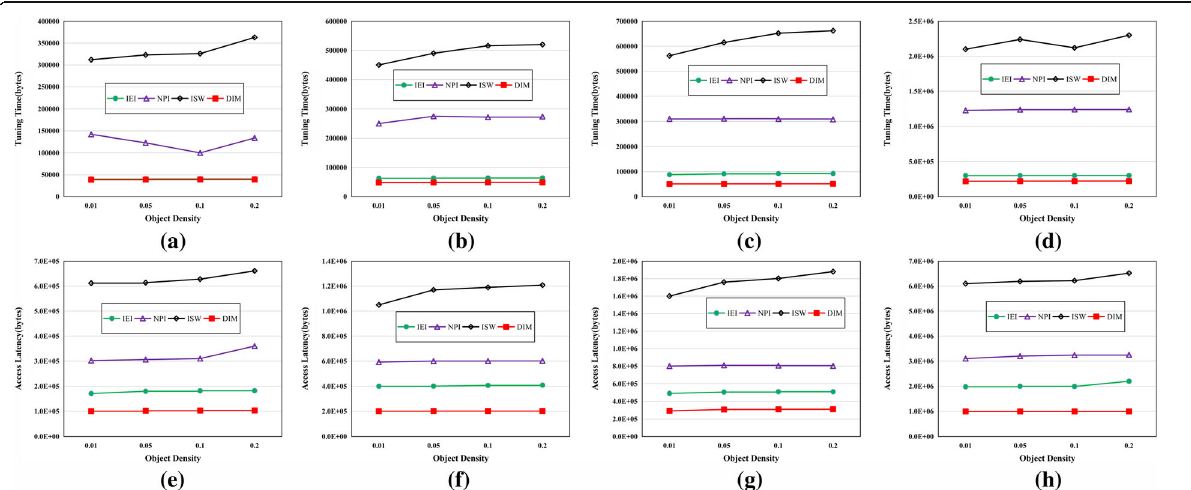
Fig. 8 Tuning time access latency of four index approaches for kNN queries versus object density. a Tuning time (OL). b Tuning time (SR). c Tuning time (CAL). d Tuning time FL. e Access latency (OL). f Access latency (SR). g Access latency (CAL). h Access latency (FL). It can be seen that the adaptation of ISW is poor when the object density increases; at the same time, both the access latency and tuning time have increasing trend. The DIM, NPI, and IEI are relatively stable, especially the DIM index proposed in this paper; its tuning time and access latency are only